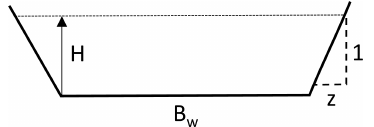
Figure B2. Schematic trapezoidal shape and related parameters of channels in WRF-Hydro. B w is the channel bottom width (m), z is the channel side slope (m), and H is water elevation (m). The cross-sectional area of flow is calculated as (B w + H z)H .